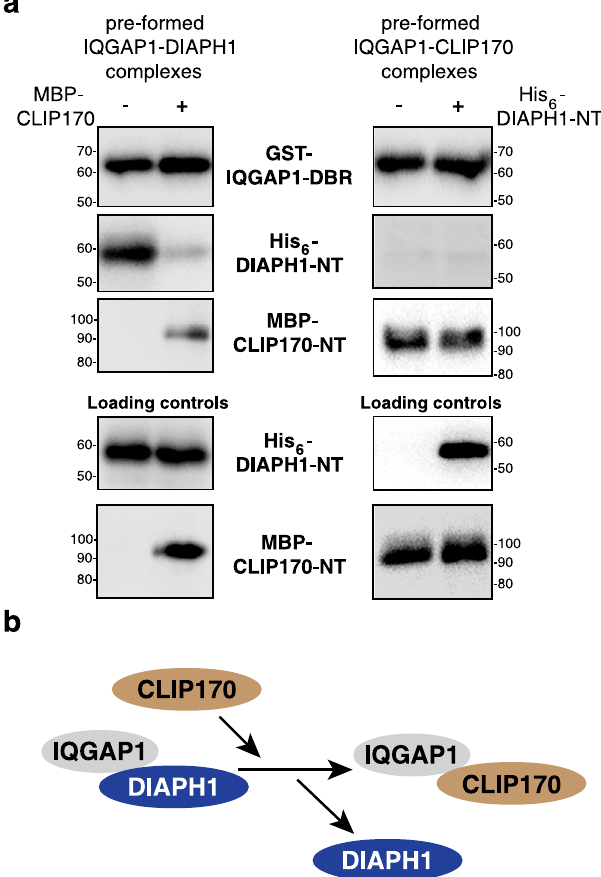
Fig. 6 IQGAP1 preferentially binds to CLIP170 over DIAPH1. a